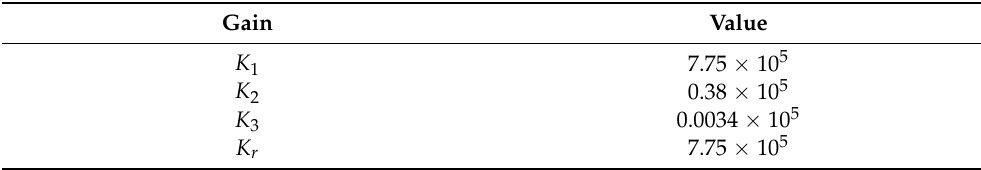
Table 2. Controller